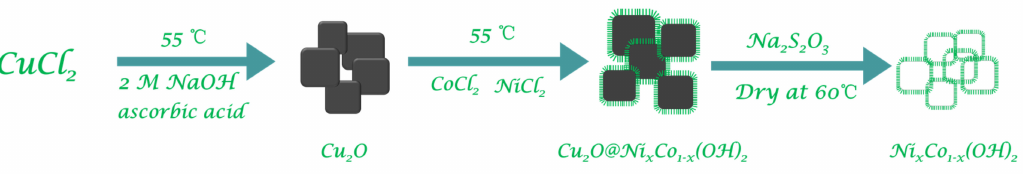
Figure 1. Schematic diagram of the synthetic procedure for the Co-Ni hydroxide nanosheets assembled the hollow cubic